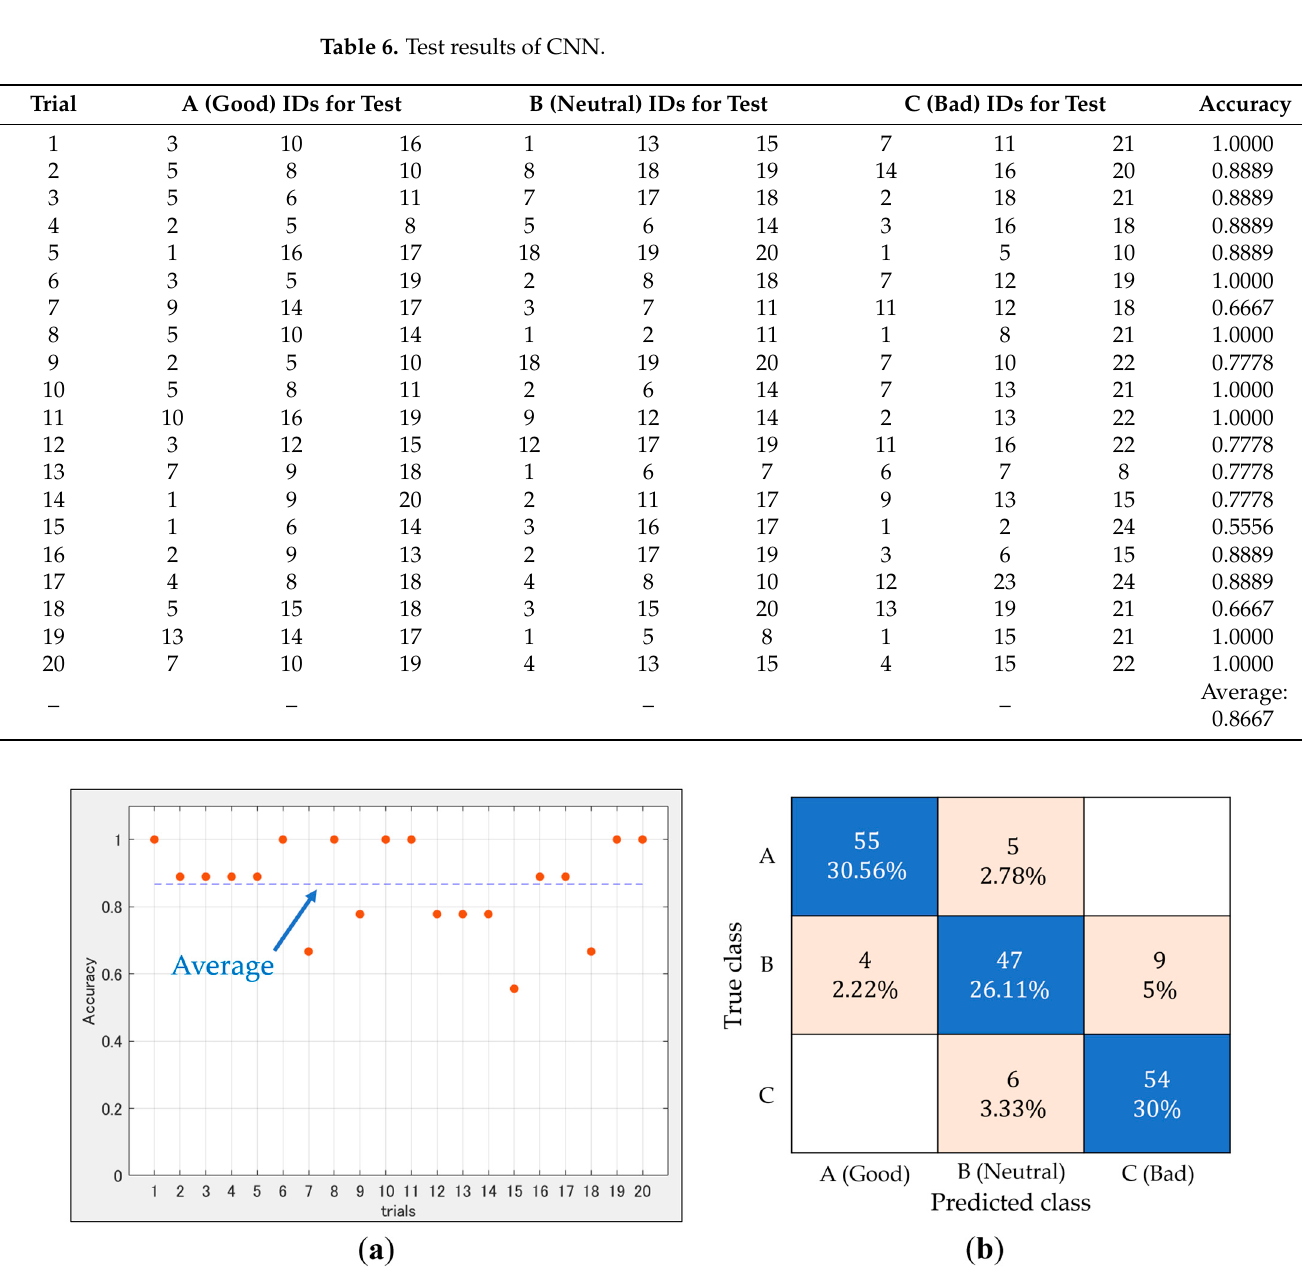
Figure 12. Test results of CNN. ( a ) Accuracies in each trial are represented with dot; ( b ) Confusion matrix in all trials.